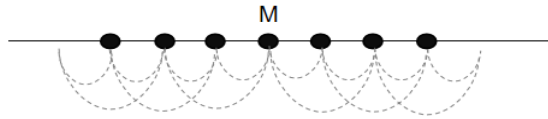
Figure 2. The selected image pairs for enhanced spectral diversity (ESD) calculation.